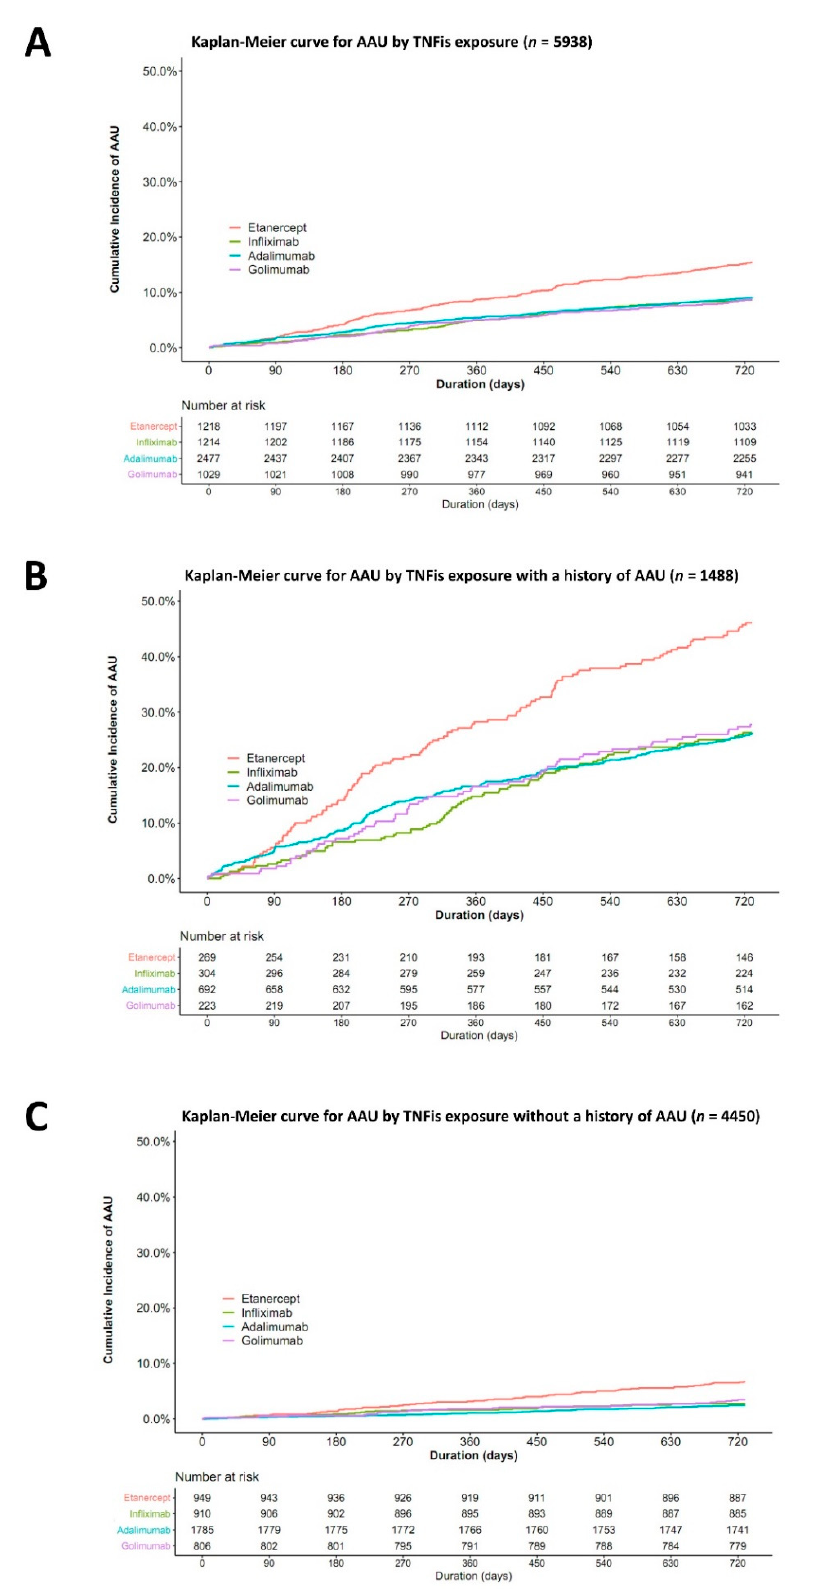
Figure 2. Cumulative probability of the occurrence of acute anterior uveitis after tumor necrosis factor alpha inhibitor initiation in overall patients ( A ) and in patients with ( B ) or without ( C ) a history of acute anterior uveitis. AAU: acute anterior uveitis, TNFis: tumor necrosis factor-alpha inhib- itors.